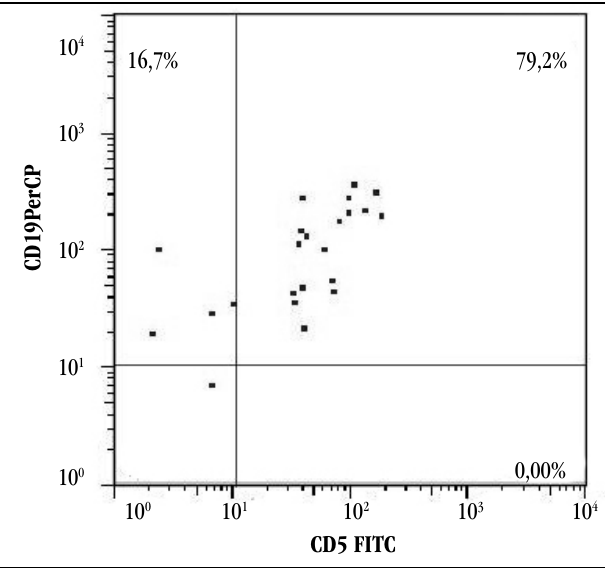
figurE – Dot-plot of the selected events according to FSC, SSC and CD45 expression consistent